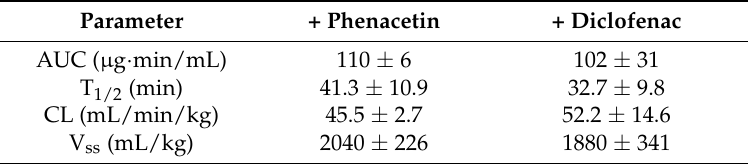
Figure 6. Plasma concentration versus time profiles of magnolol in rats following its intravenous injection at a dose of 5 mg/kg with concurrent administration of 20 mg/kg oral phenacetin (●) or 6 mg/kg diclofenac ( ○ ). The bullet symbols and their error bars represent the means and standard deviations, respectively ( n = 4). Table 4. Pharmacokinetic parameters of magnolol in rats following its intravenous injection at a dose of 5 mg/kg with 20 mg/kg oral phenacetin or 6 mg/kg diclofenac ( n = 4).